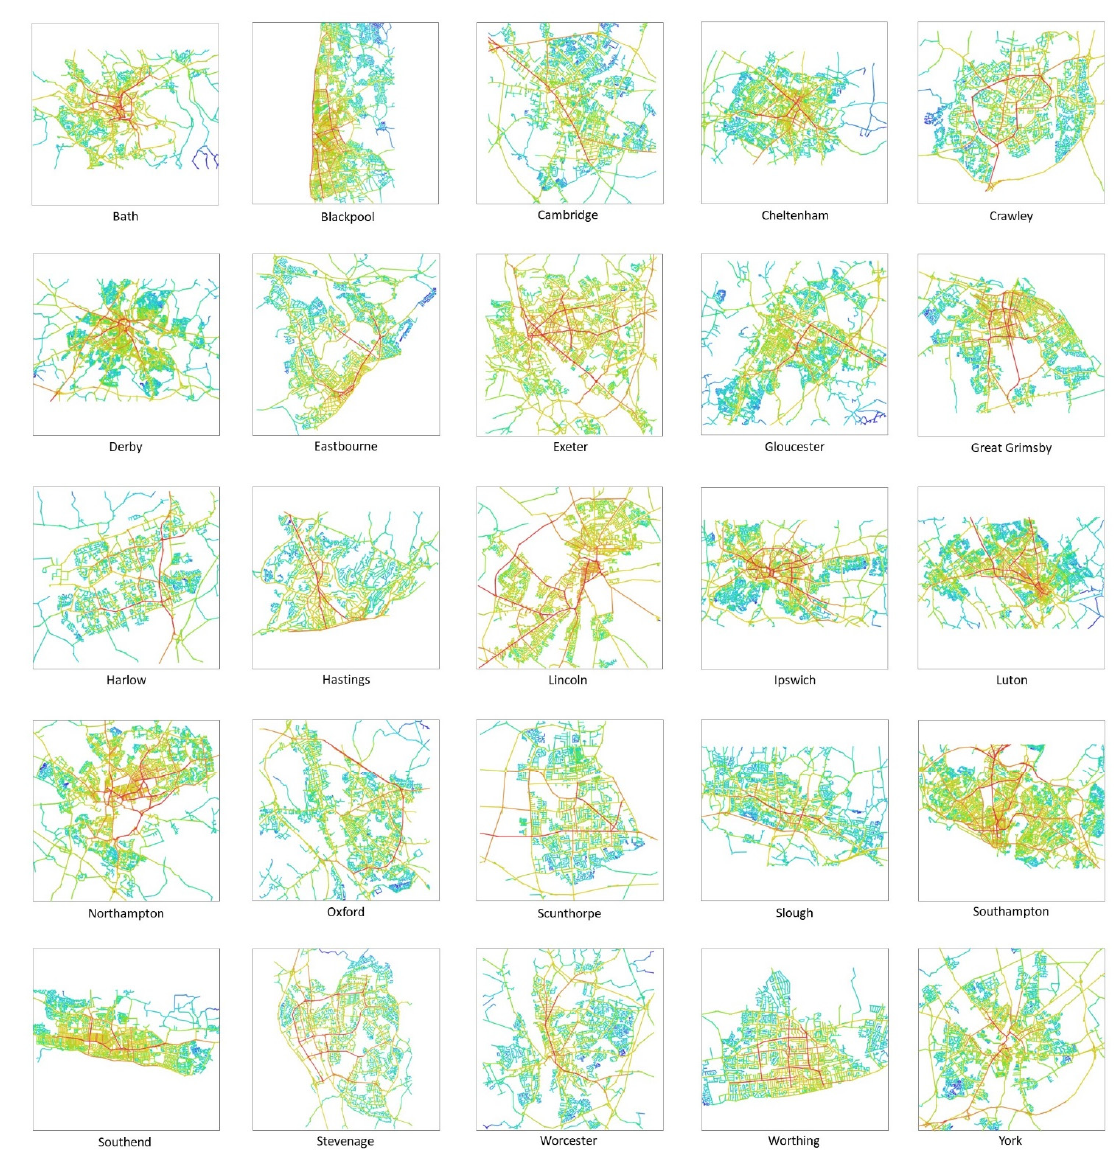
Figure 3. The segment maps of the 25 cities in the study sample colored using integration Rn. The colors range from red, for segments with high integration values, to blue, for segments with low integration values. The distribution of the most integrated segments in these maps shows linear patterns (e.g., Cambridge, Worcester), radial patterns (e.g., Derby, Exeter), deformed grid-like patterns (e.g., Stevenage, Worthing), deformed grid-like patterns with radiating lines (e.g., Ipswich, Lincoln), and so on. These differences indicate different patterns of accessibility and movement in these